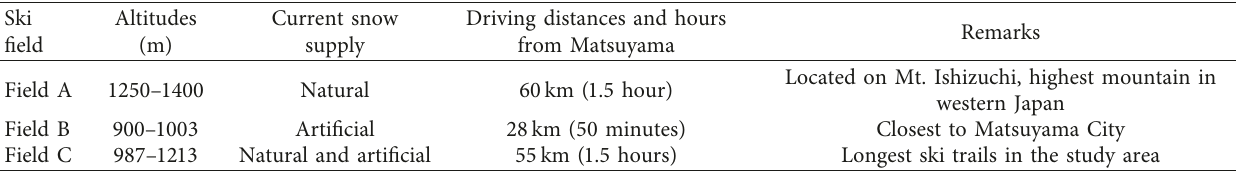
Figure 1: Maps of the study area. Fields A ∼ C show locations of the targeted ski fields. Matsuyama is the capital city of Ehime Prefecture, and Kuma AMeDAS is an automated meteorological observation station whose data are used for bias correction of simulated surface air temperature from the NHRCM. Table 1: Summary of key features of the targeted ski